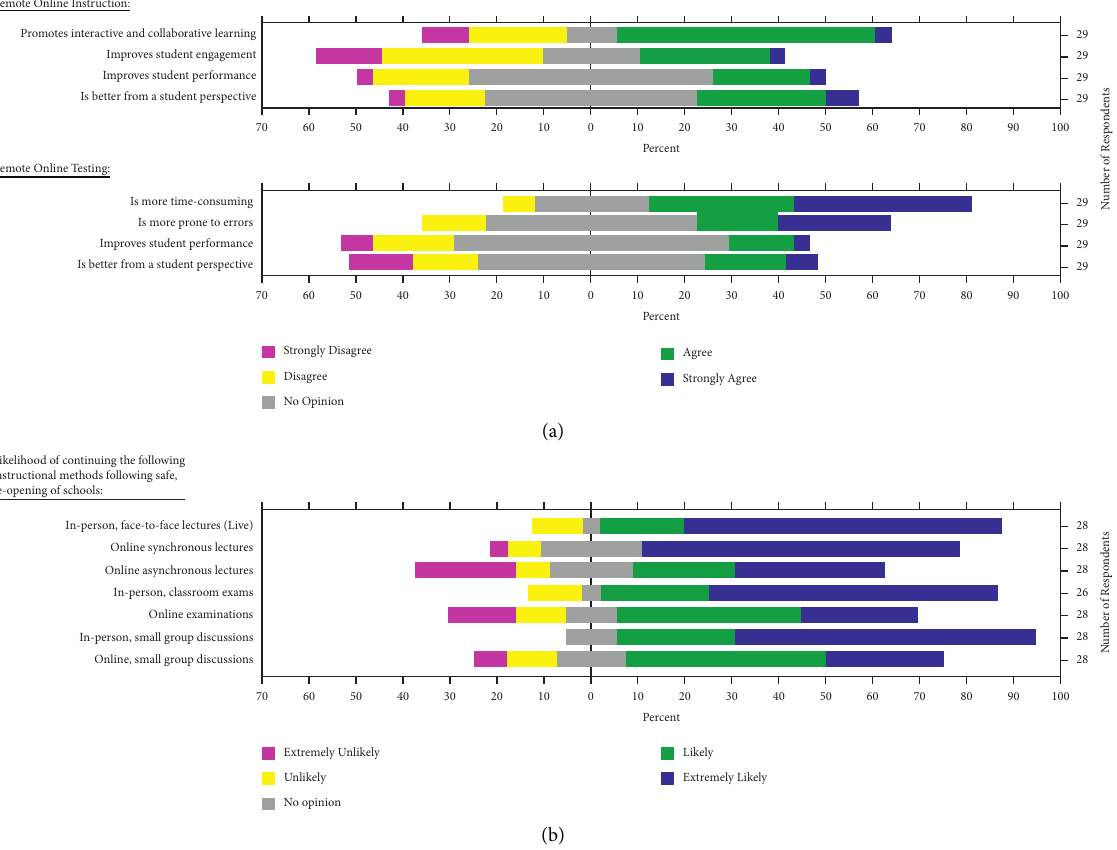
Figure 1: Faculty perception of online instruction